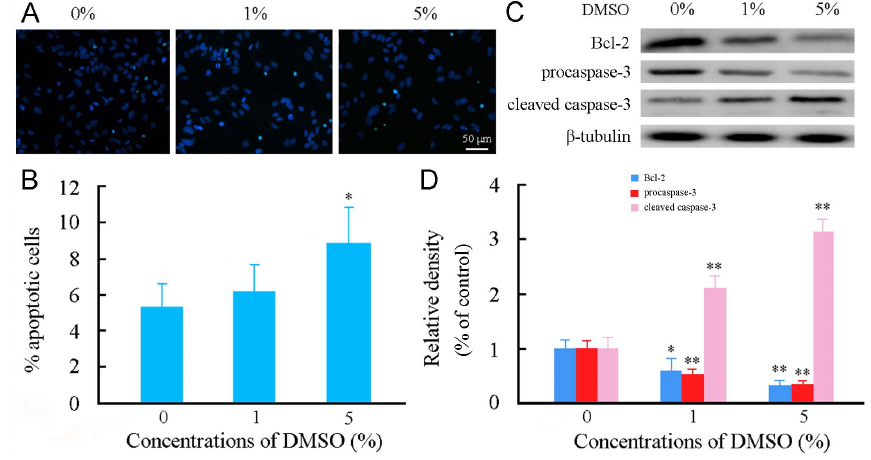
Figure 6. Effects of DMSO on apoptosis of cultured mouse cortical astrocytes. Astrocytes were incubated with various concentrations of DMSO for 24 h. (A) Representative micrographs showing TUNEL positive apoptotic astrocytes (cyan-blue). Cell nuclei counterstained with Hoechst 33342 (blue). (B) Quantitative analysis of astrocyte apoptosis. (C) Representative western blot bands showing expression levels of procaspase-3, cleaved caspase-3 and Bcl-2 in astrocytes. (D) The quantitative analysis showed that Bcl-2 and procaspase-3 expression levels were decreased, but cleaved caspase-3 expression level was increased in astrocytes treated with 1% or 5% DMSO. Data are shown as a mean 6 SEM of five (for TUNEL) or four (for Western blot) independent experiments performed in triplicate. * P , 0.05 and ** P , 0.01 versus control group.